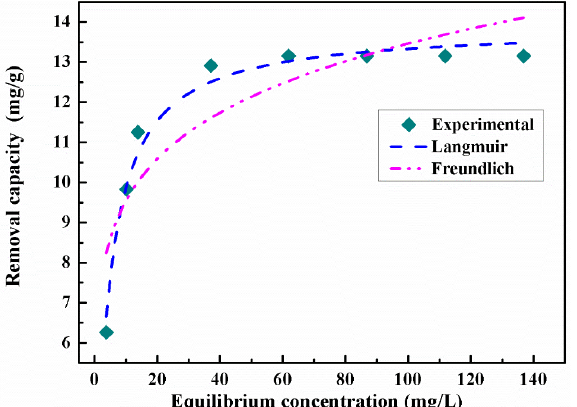
Figure 7. Effect of initial concentration on As(V) adsorption.